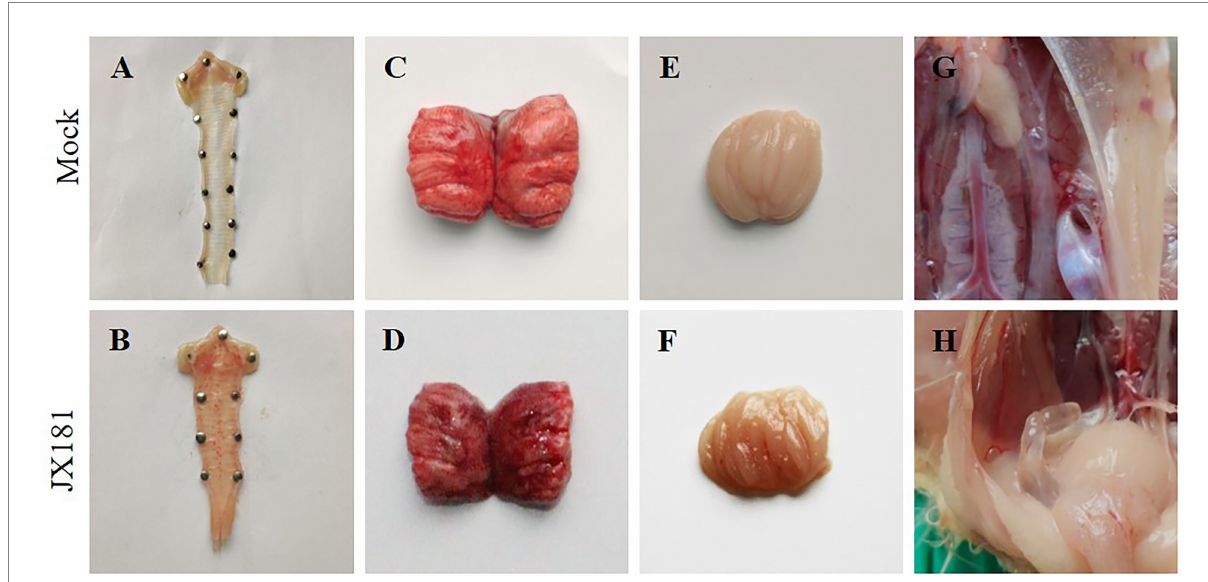
FIGURE 1 Gross lesions in the different organs of chicks inoculated with strain JX181. 10-day-old chicks were challenged with 10 6.5 EID 50 of JX181 via the ocular–nasal route. The representative gross lesions of the chicks sacrificed at 6 dpi were shown in (A,B) Larynx and trachea, (C,D) Pulmonary congestion, (E,F) Bursa of Fabricius, (G,H)